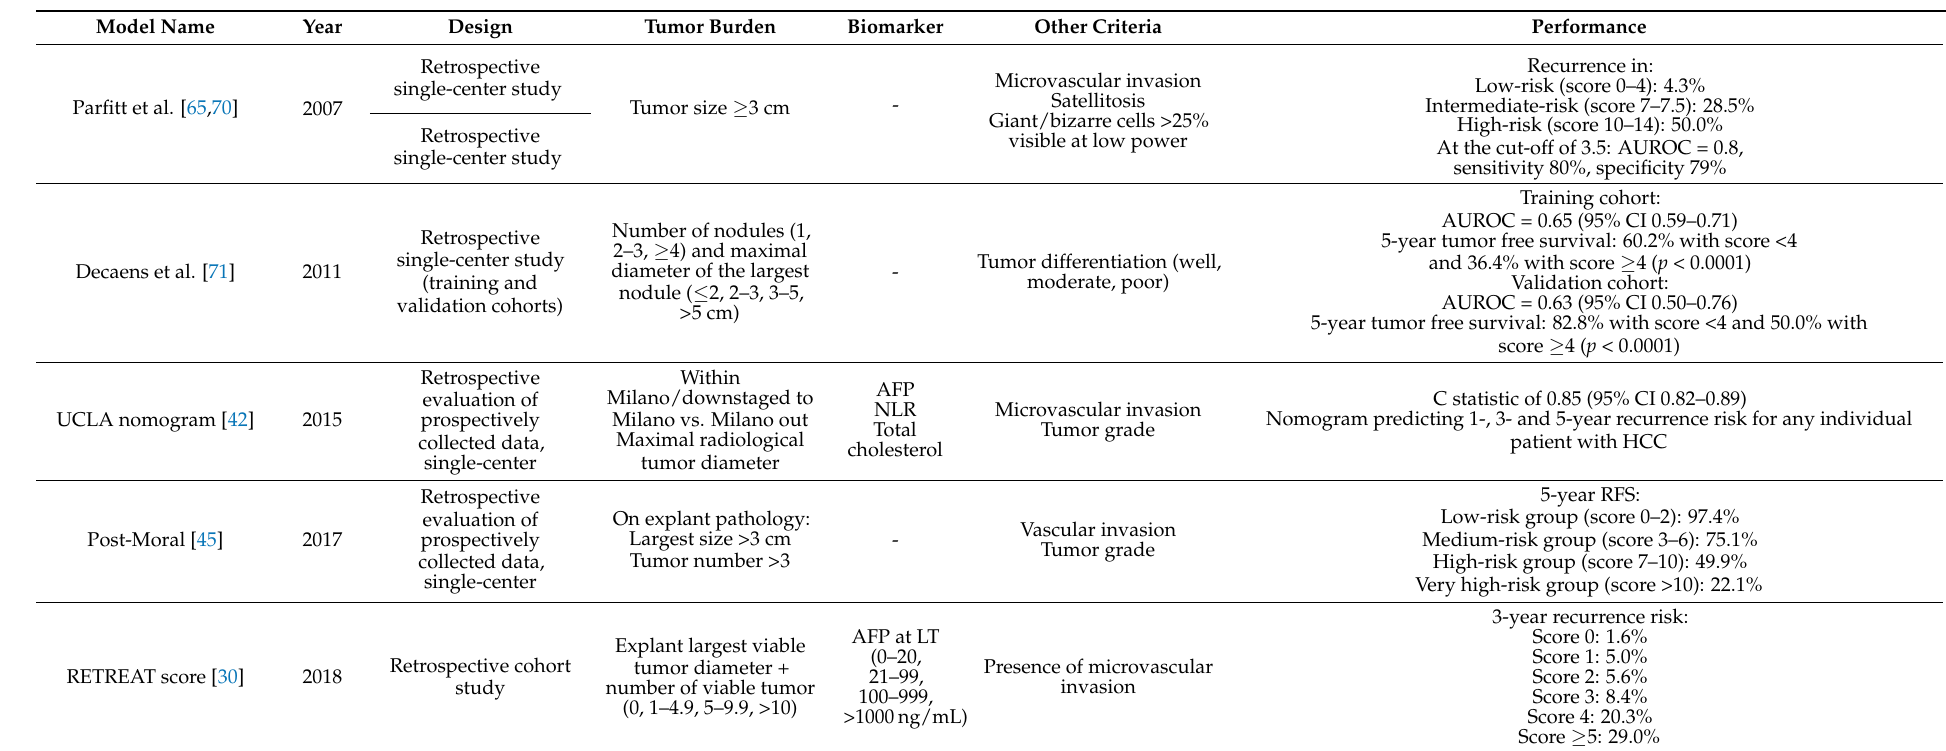
Table 3. Proposed post-transplant scoring